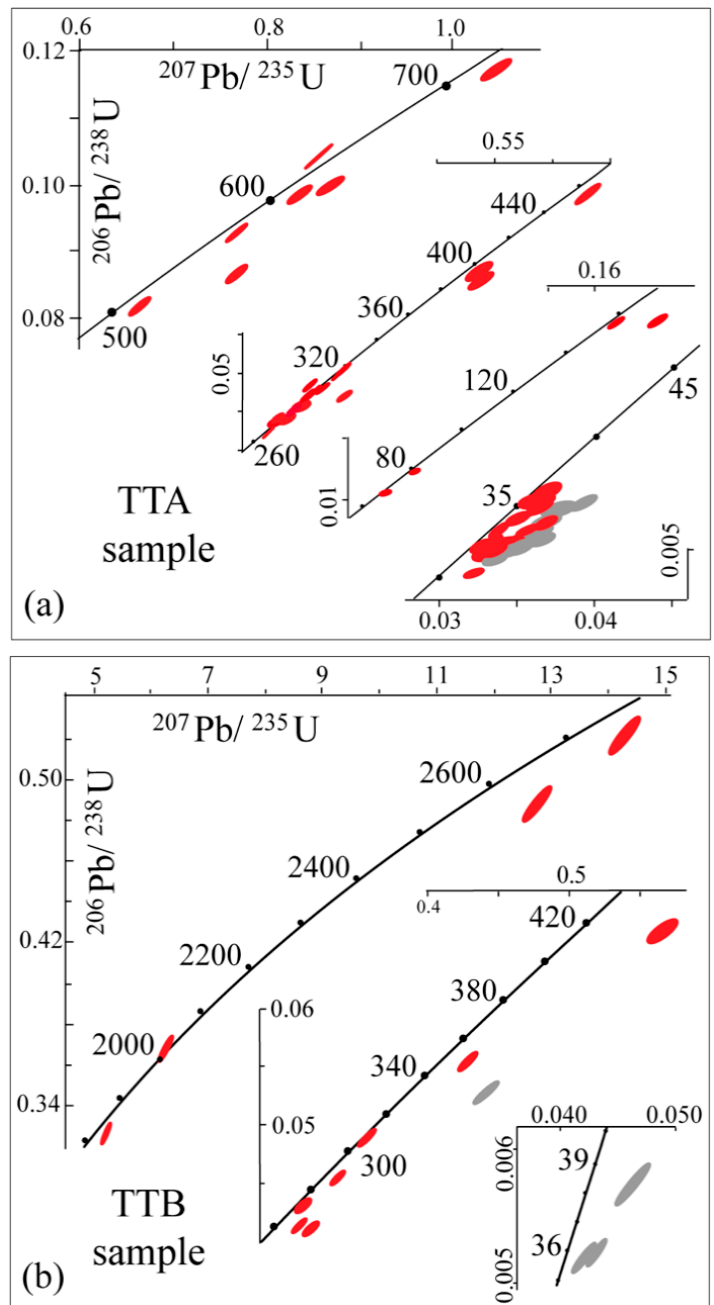
Figure 9. Concordia plot of the U-Pb ages in the TTA ( a ) and TTB ( b ) samples. Ellipses represent the ages with 2 σ uncertainties. Red ellipses: Ages with % U-Pb discordance < ± 10%; grey ellipses: Sub-concordant ages with % U-Pb discordance comprised between 10% and 27%.